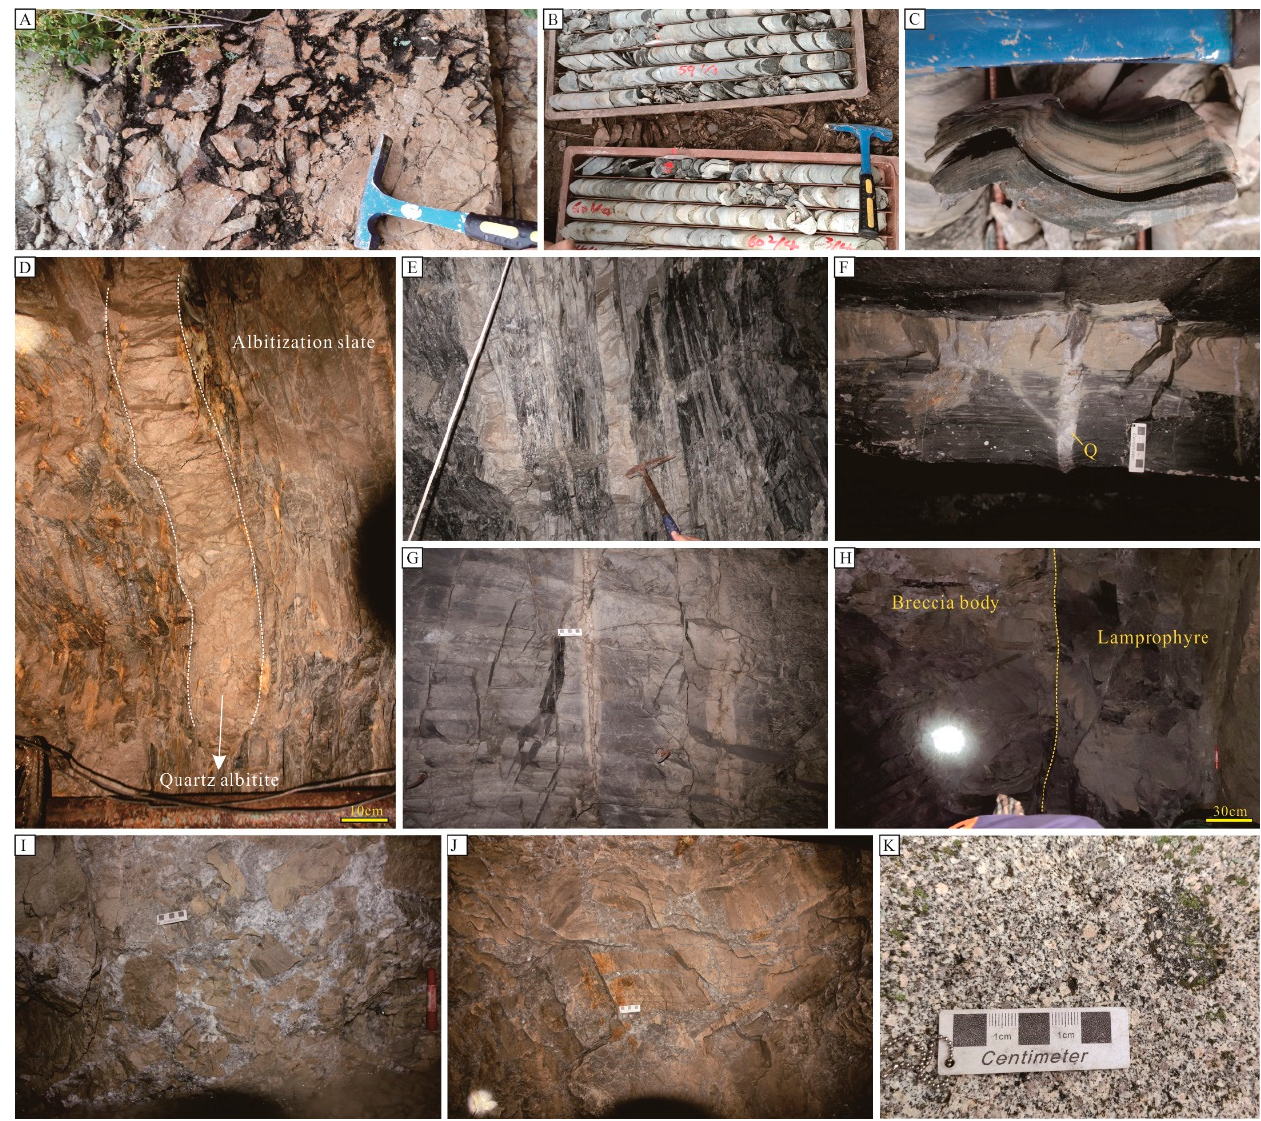
Figure 4. ( A ) Outcrop of the breccia body; ( B , C ) Transition zone of wallrock alteration; ( D ) Quartz albitite dike intruding into albitization slate; ( E – G ) Slate accompanied by partial albitization; ( H ) Lamprophyre intruding into breccia body; ( I , J ) Breccia body; ( K ) Granodiorite of the Xiba pluton.